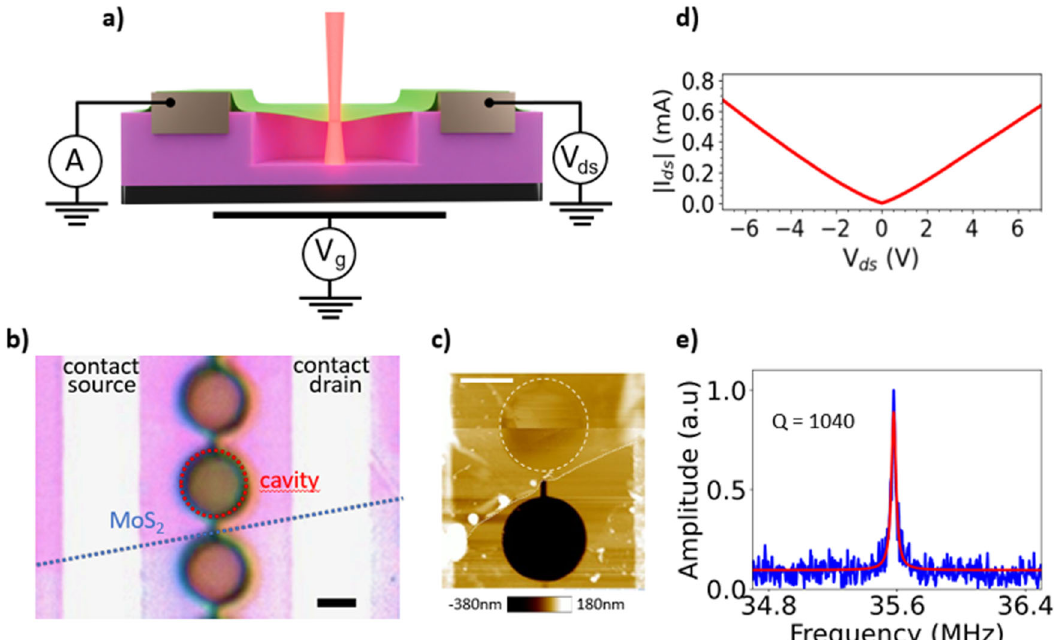
Fig. 1 Opto electromechanical setup. a Schematic of the suspended MoS 2 membrane in a back-gate transistor con fi guration, contacted laterally by two gold electrodes. b Optical microscopy image of the sample. Dotted lines are guide to the eye to locate the cavity and the MoS 2 crystal, scale bar is 2 µm. c Atomic force microscopy image of the suspended fl ake used for thermal measurements, scale bars is 2 µm. d Electrical characteristic I ds ( V ds ) of the sample ( e ) Mechanical response of the assembled membrane near 35.6 MHz, as measured by our optical technique. The quality factor at room temperature is Q =